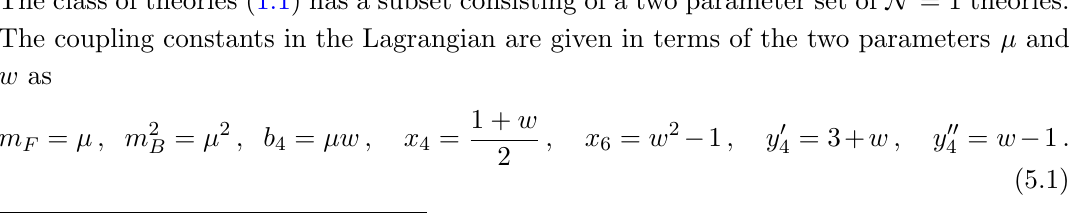
Figure 17. The phase diagram ellipsoid of the N = 2 theory for the value j (cid:21) j = 3 order phase transition line in green is on the far side of the ellipsoid. Note that the (cid:12)rst order line meets the dashed blue lines described by regular fermion CFTs. These meeting points themselves are described by critical fermion CFTs. The solid blue lines are described by critical boson CFTs and the intersection point of the two solid and two dashed blue lines is described by the CB-RF CFT. The features of this phase diagram can be obtained by applying the duality map (1.3) to the case j (cid:21) j = 1 4